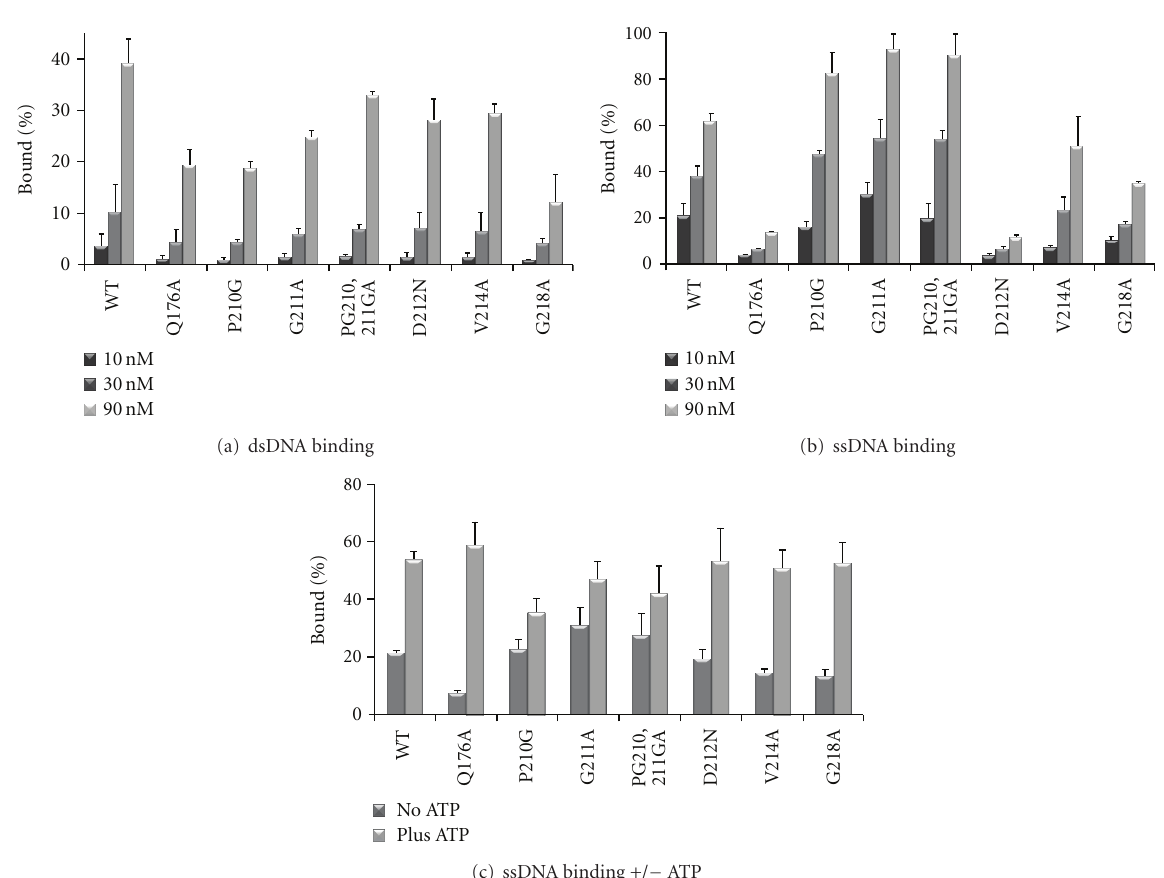
(c) ssDNA binding +/ − ATP Figure 4: ss and dsDNA binding by the mutant MCM proteins. Nitrocellulose filter binding assays were performed as described under “Section 2” using 50fmol of 32 P-labled ds (a) or ss (b) DNA (49-mer) in the presence of 10, 30, and 90 nM of proteins (as monomer). (c) ssDNA binding assay contained 25nM protein (as monomer) in the absence or presence of 1mM ATP. The average results of three independent experiments with standard deviations are